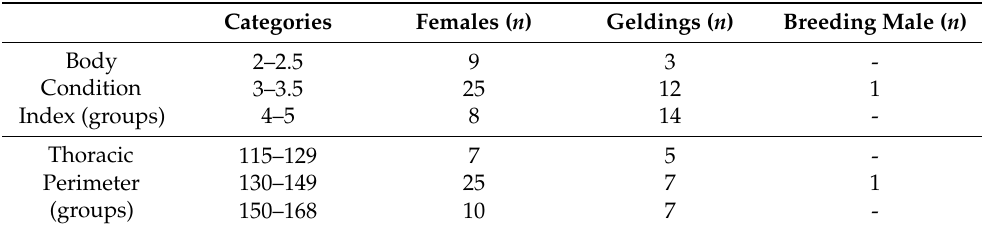
Table 3. Summary of data considering categories of body condition index and thoracic perimeter per